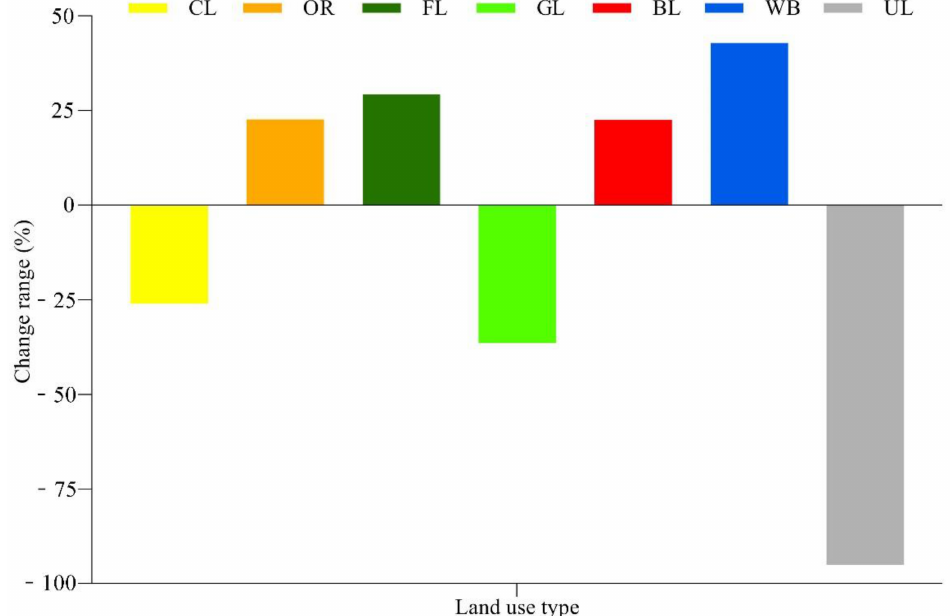
Figure 2. Land use changes in Pu County between 2009 and 2019. Notes: CL, OR, FL, GL, BL, WB, and UL represent cropland, orchard, forest land, grassland, built-up land, water bodies, and unused land,